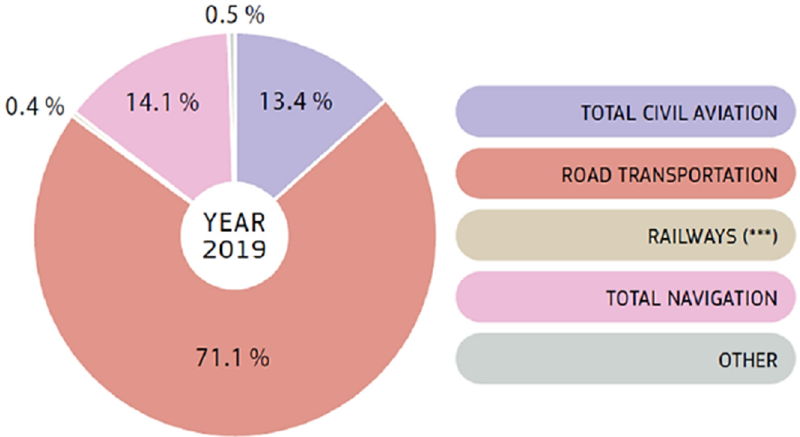
Figure 2. GHG emissions [%] from transport in EU-27 during 2019, divided by modes; (***) excluding indirect emissions from electricity consumption; from [1].